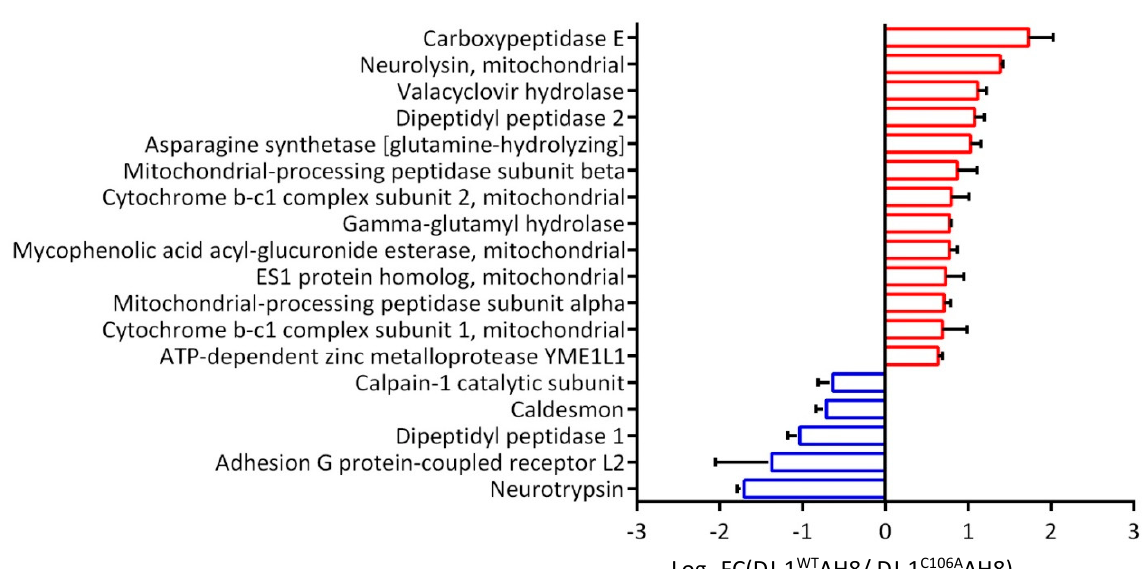
Figure 4. Effect of DJ-1 ∆ H8 overexpression on the abundance of other proteases: Proteases with significantly altered abundance in the quantitative proteome comparison of DJ-1 WT ∆ H8 and DJ-1 C106A ∆ H8 overexpressing differentiated SH-SY5Y cells (log2 FC ≤ − 0.58 or ≥ 0.58) in two of three experiments and p -value ≤ 0.05).